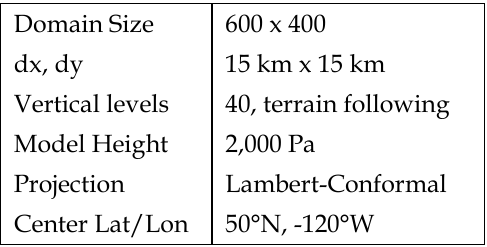
Table 1: Domain parameters for